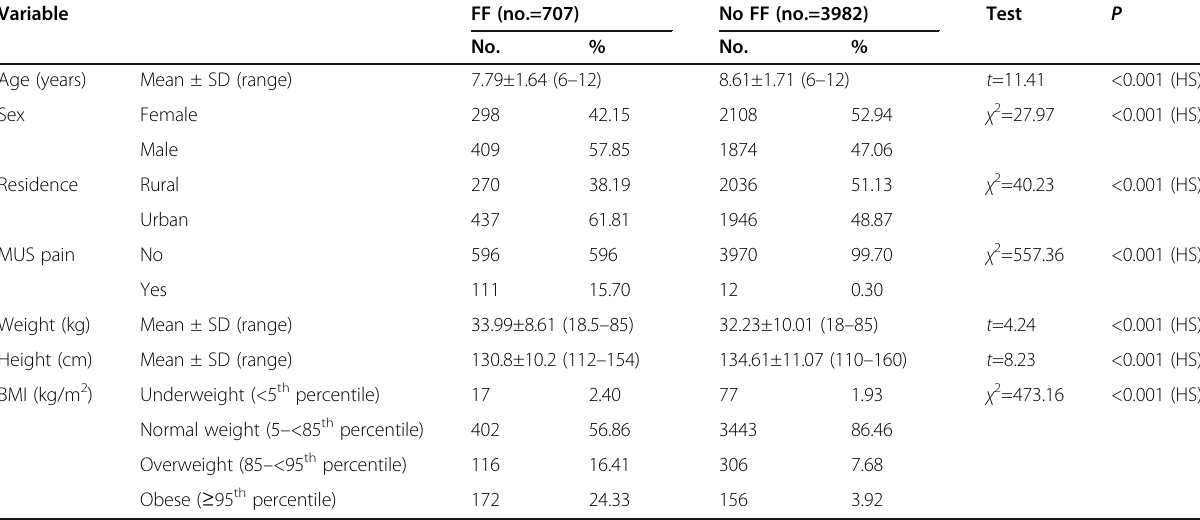
Table 2 Relations between the flat foot, demographic, and clinical findings among the studied children Variable